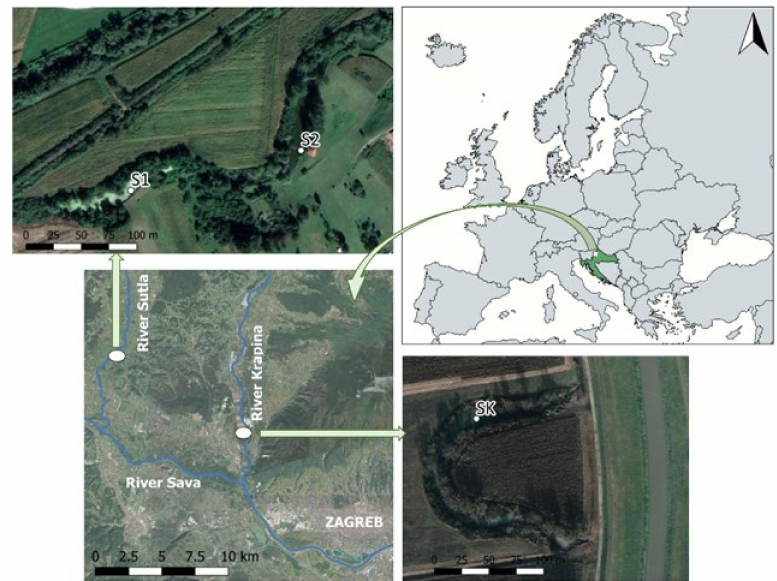
Figure 1. Map showing the schematic and satellite location of the investigated shallow waterbodies in Croatia with marked sampling sites in the littoral of: S1—Sutla backwater basin with submerged macrophytes (45 ◦ 54 (cid:48) 51 (cid:48)(cid:48) N, 15 ◦ 41 (cid:48) 48 (cid:48)(cid:48) E), S2—Sutla backwater without macrophytes (45 ◦ 54 (cid:48) 53 (cid:48)(cid:48) N, 15 ◦ 41 (cid:48) 56 (cid:48)(cid:48) E), SK—Škrˇcev kut oxbow (45 ◦ 51 (cid:48) 45 (cid:48)(cid:48) N, 15 ◦ 49 (cid:48) 29 (cid:48)(cid:48)